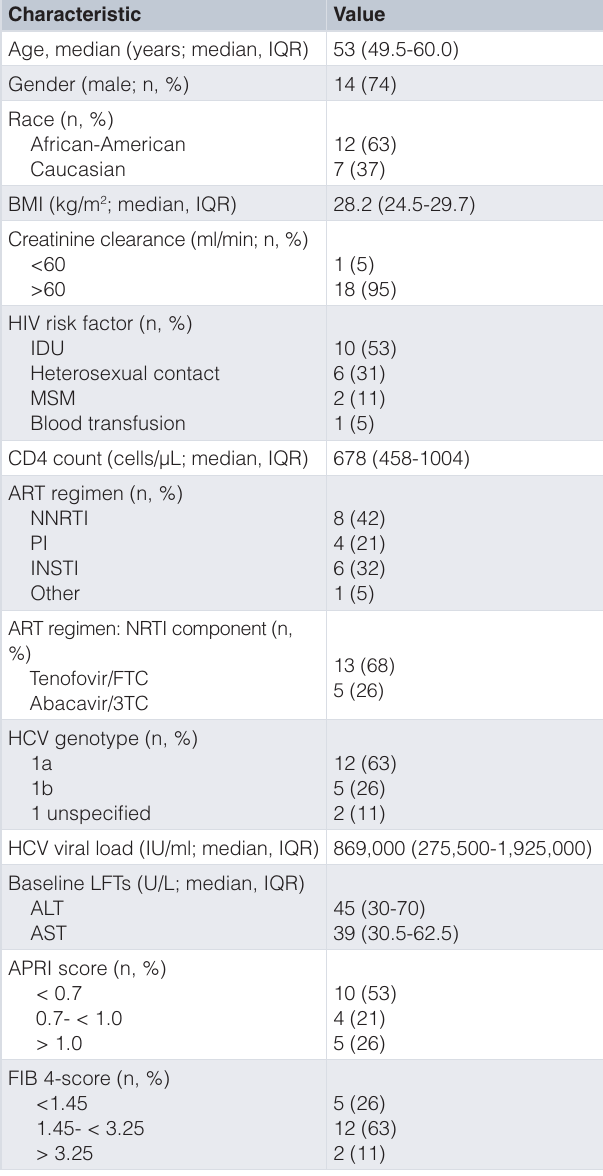
Table 1. Baseline demographic and clinical characteristics of 19 HIV and HCV co-infected patients treated with an 8 week course of sofosbuvir and ledipasvir.